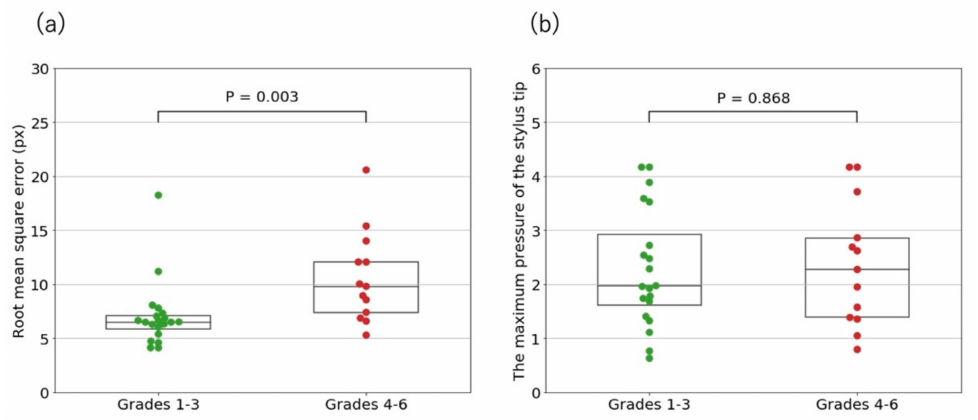
Figure 6. The CTS group was divided into two groups, patients with CTS grades 1–3 and those with CTS grades 4–6, based on the Bland classification. ( a ) Comparison of root mean square errors between the participants’ spirals and the model spiral in the patients with CTS grades 1–3 and those with CTS grades 4–6. There was a significant difference between the grades. ( b ) Comparison of the maximum pressures of the stylus tip between patients with CTS grades 1–3 and those with CTS grades 4–6.